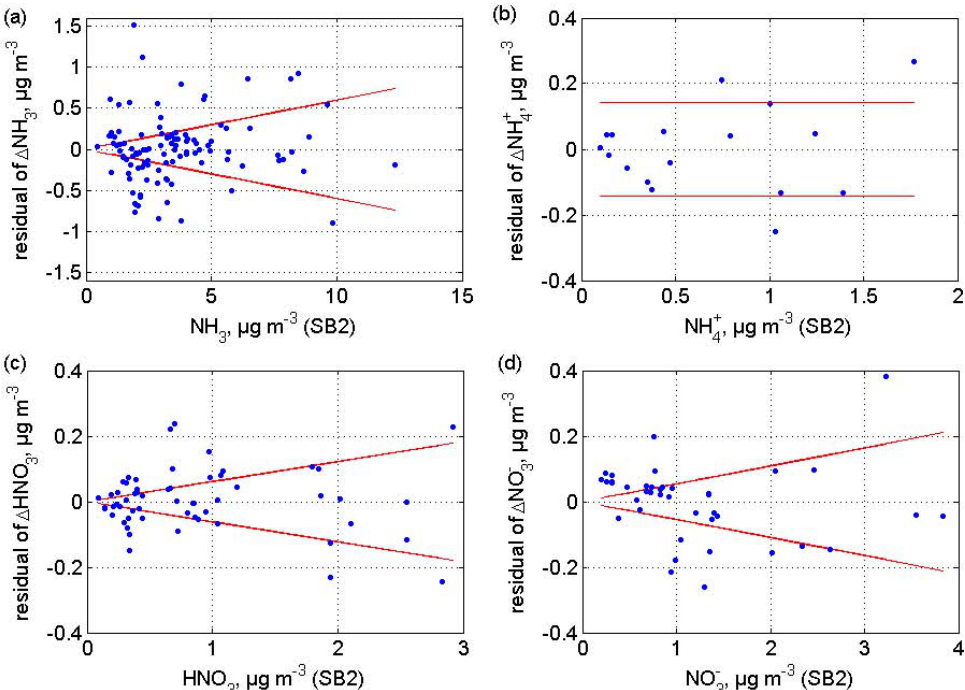
Fig. 10. Residuals of 1C during side-by-side after correcting the data for systematic deviations using the orthogonal fit (individual values: blue points) and their relation to C during NEU. The derived σ 1C is shown as red line (uncertainty range around zero).